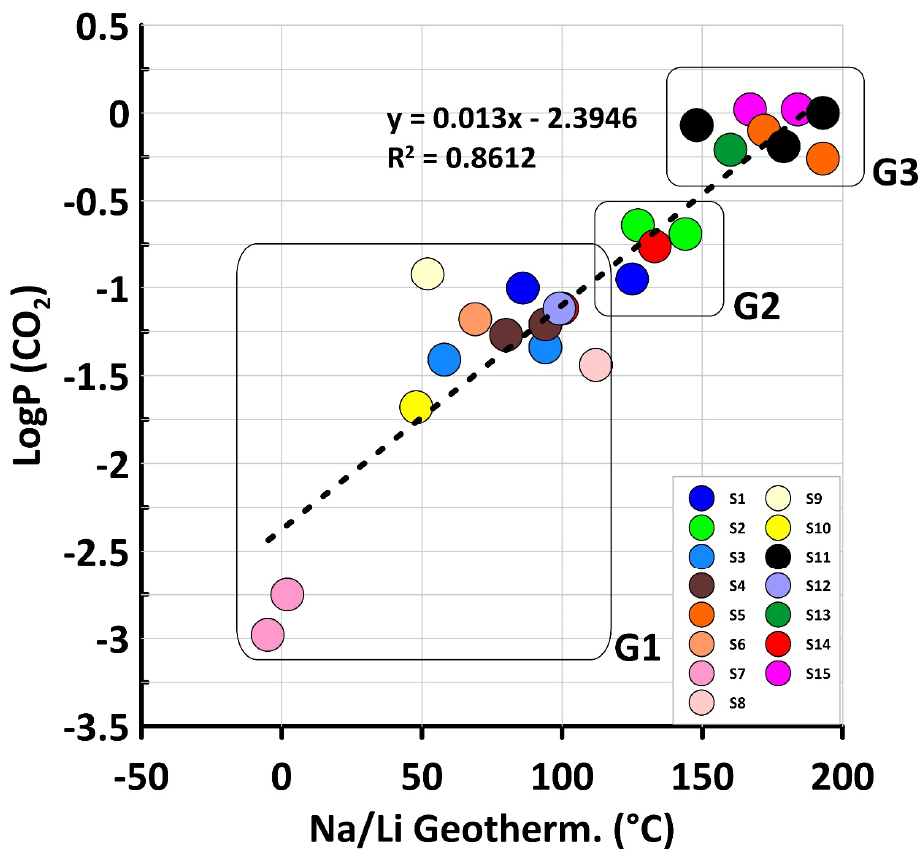
Figure 5 . LogP(CO 2 ) at sampling conditions calculated by PHREEQCi [75] versus T, where T = temperature in °C obtained from an Na-Li geothermometer [96]. A high coefficient of determination (R-squared value = 0.86) for the groundwater samples from the San Vittorino Plain was found. See Figure 1 for spring location. G1, G2 and G3 refer to new spring groups.